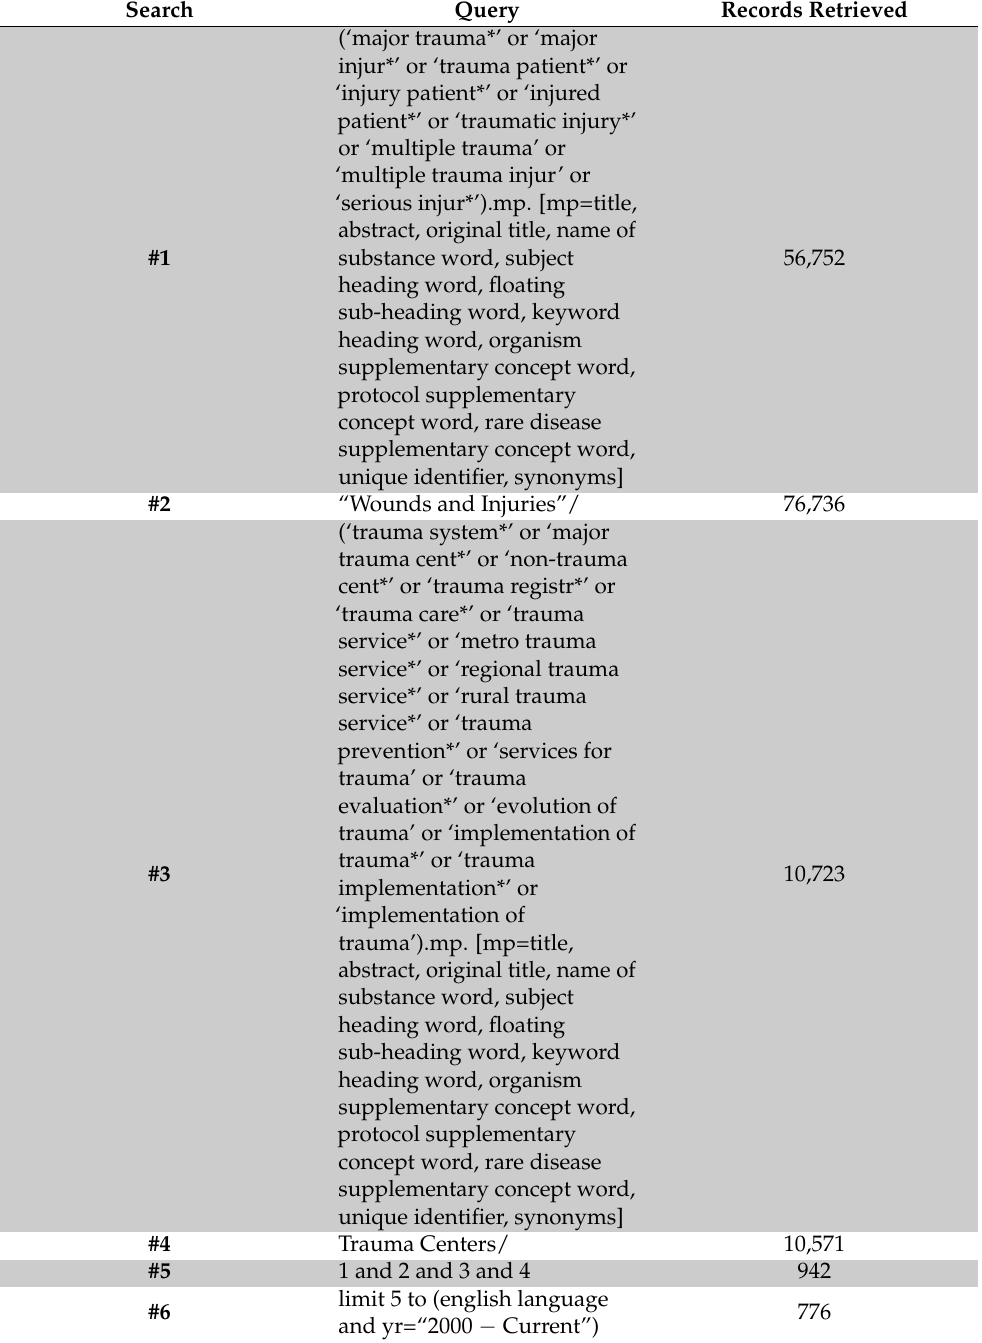
Table A1. Search strategy for PubMed/MEDLINE and EMBASE via Ovid (search conducted: 20 June 2020).